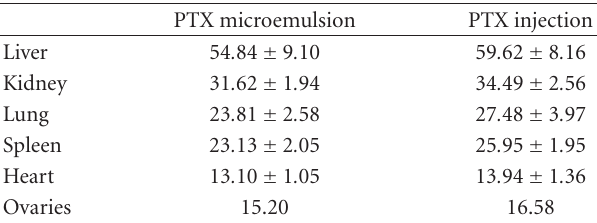
Table 3: The AUC 0–8 values of PTX after intravenous administra- tion of the PTX injection or microemulsion at 5mg/kg of PTX in SD rats (mean ± S.D., n = 3).